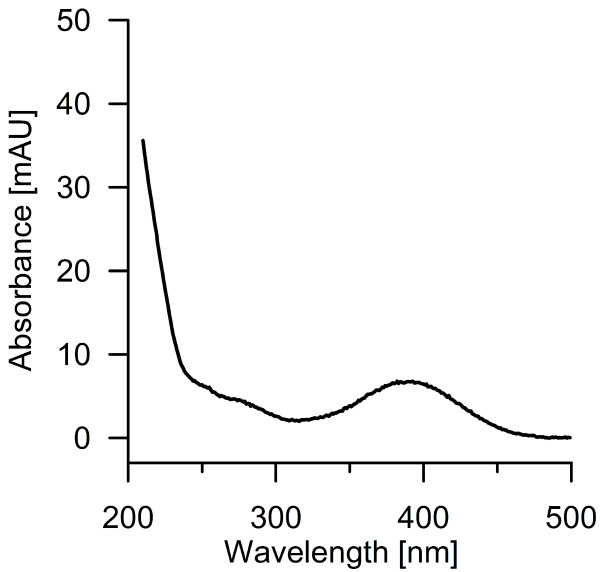
UV/vis-spectrum of a short-lived benzene oxidation product found at low pH (<4),probably representing o-benzoquinone (Albarran et al.2010).